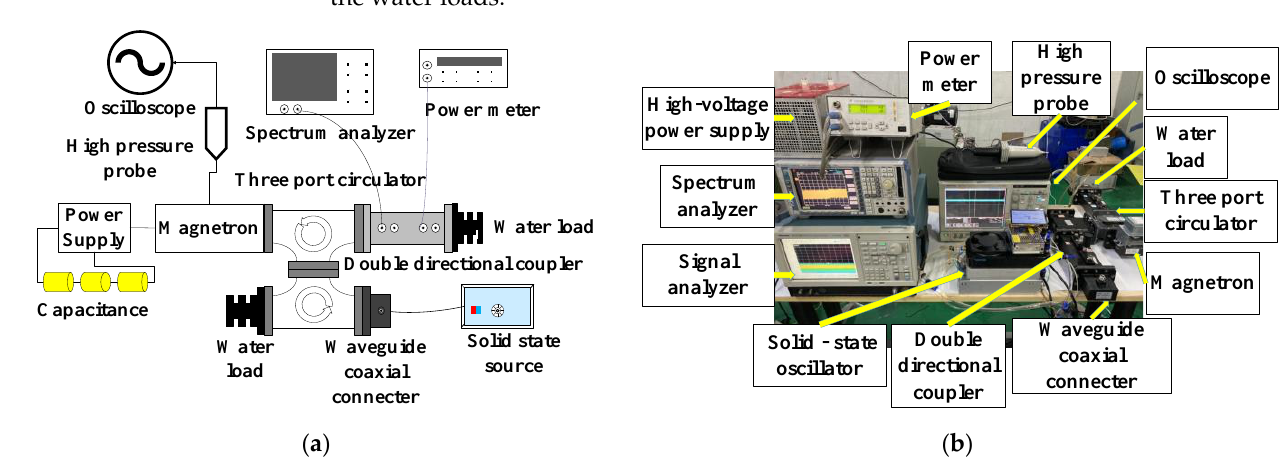
Figure 4. ( a ) Experimental schematic diagram, and ( b ) Photograph of the experimental system.